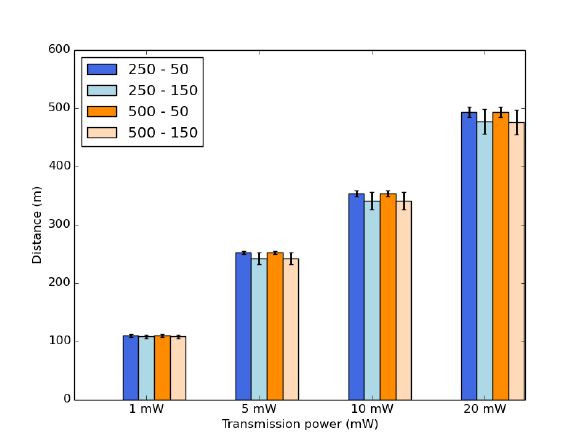
Figure 13. Average communication range.